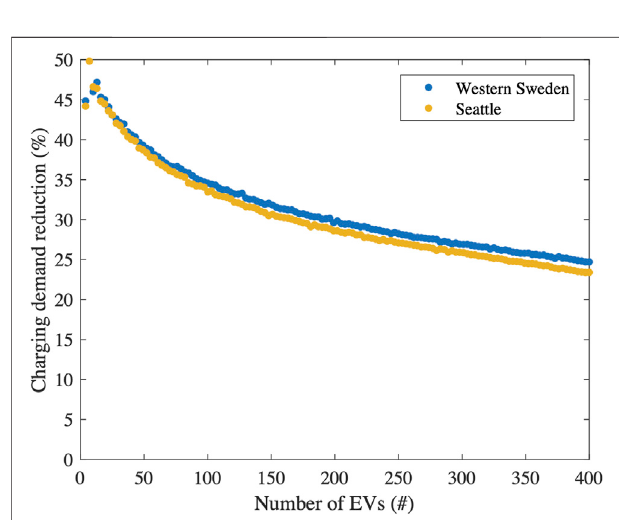
FIGURE 7 | Charging demand reduction when moving the 364 highest charging demand hours for 1 year. The nominal charging power is 11 kW, the electricity demand per km is assumed to be 0.2 kWh/km and charging location is home